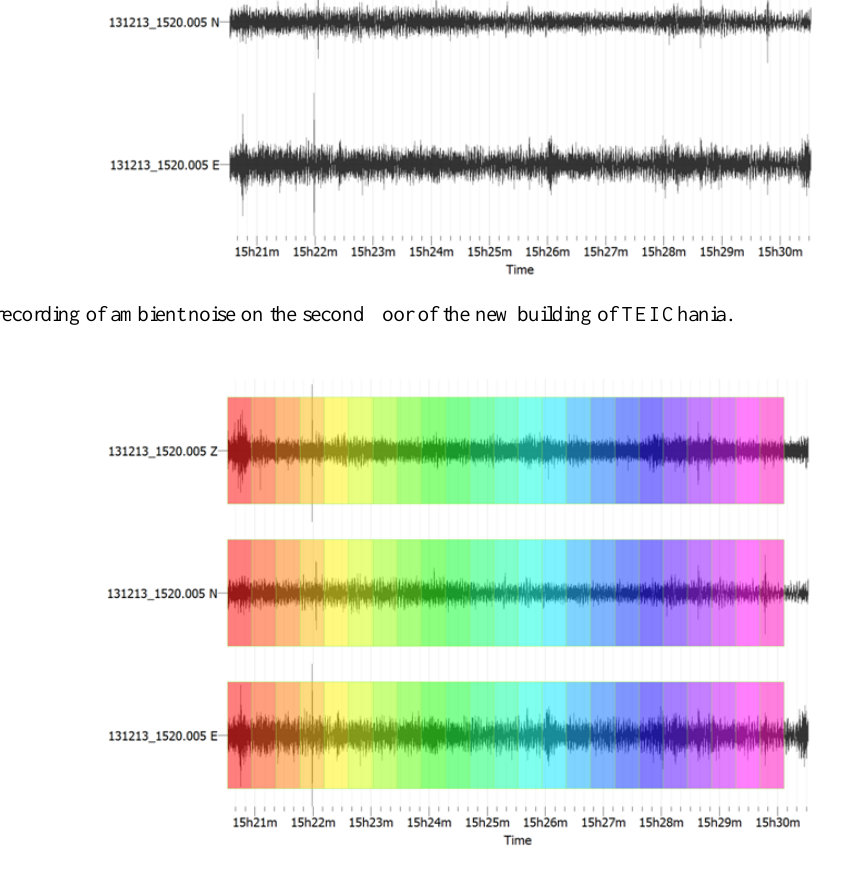
Figure 8. The time window (top) of 25s for the previous recording with the HVSR result (bottom). Different colours corresponding in different time windows. Grey background colour presents the automatic recognition of fundamental frequency of the Geopsy